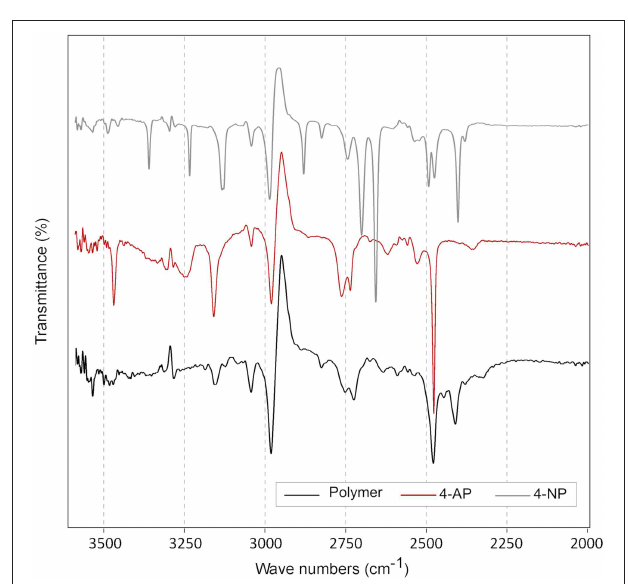
FIGURE 8 | Fourier transform infrared spectra (FT-IR) of 4-AP, 4-NP and the unknown brown precipitate labeled “polymer” in the figure legend. The three compounds were solubilized in DMSO. The transmittance between 2,000 and 3,500 cm − 1 were presented in this figure. No differences were observed at lower wave